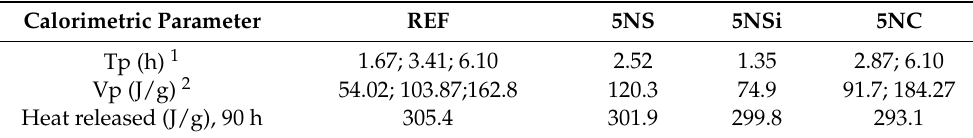
Table 1. Isothermal conduction calorimetry parameter values.